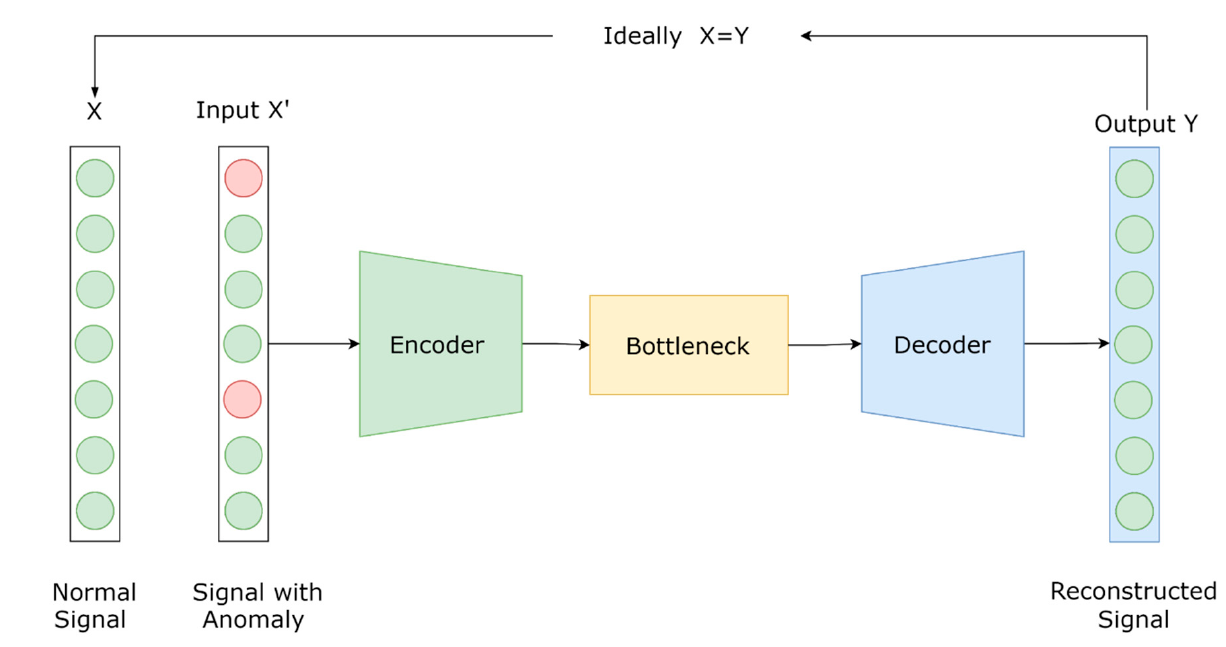
Figure 1. Illustration of an autoencoder architecture.